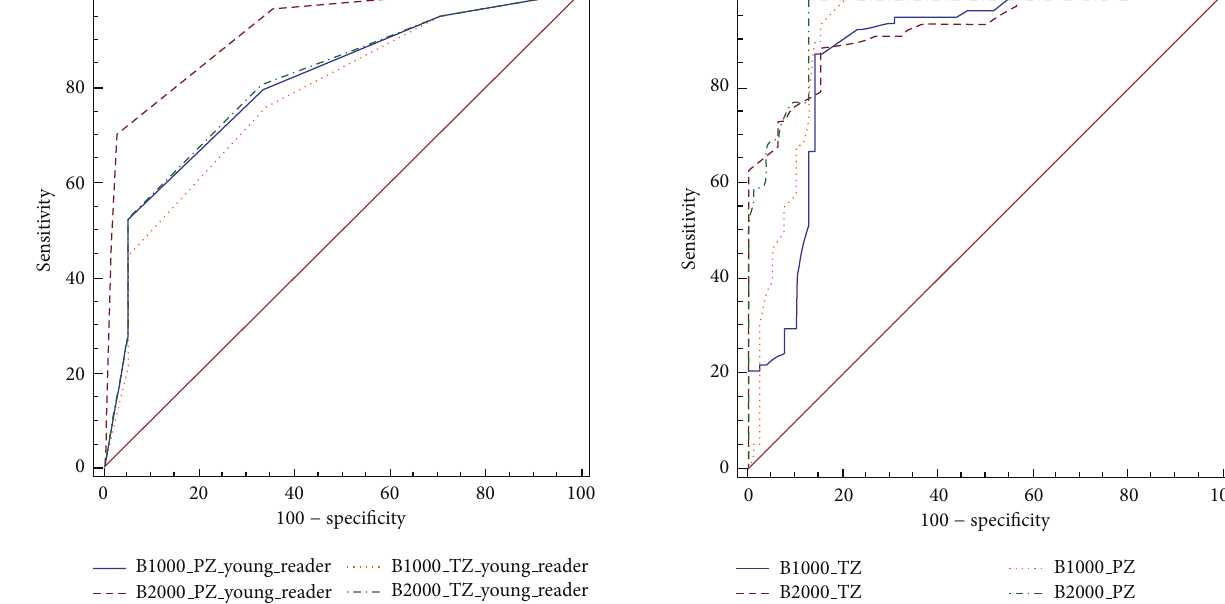
Figure 5: ROC curves for the young reader for detection of prostate cancer in the PZ (blue and red lines) and TZ (yellow and green lines) using native DWI images at 𝑏 -values of 1000 s/mm 2 and 2000 s/mm 2 .